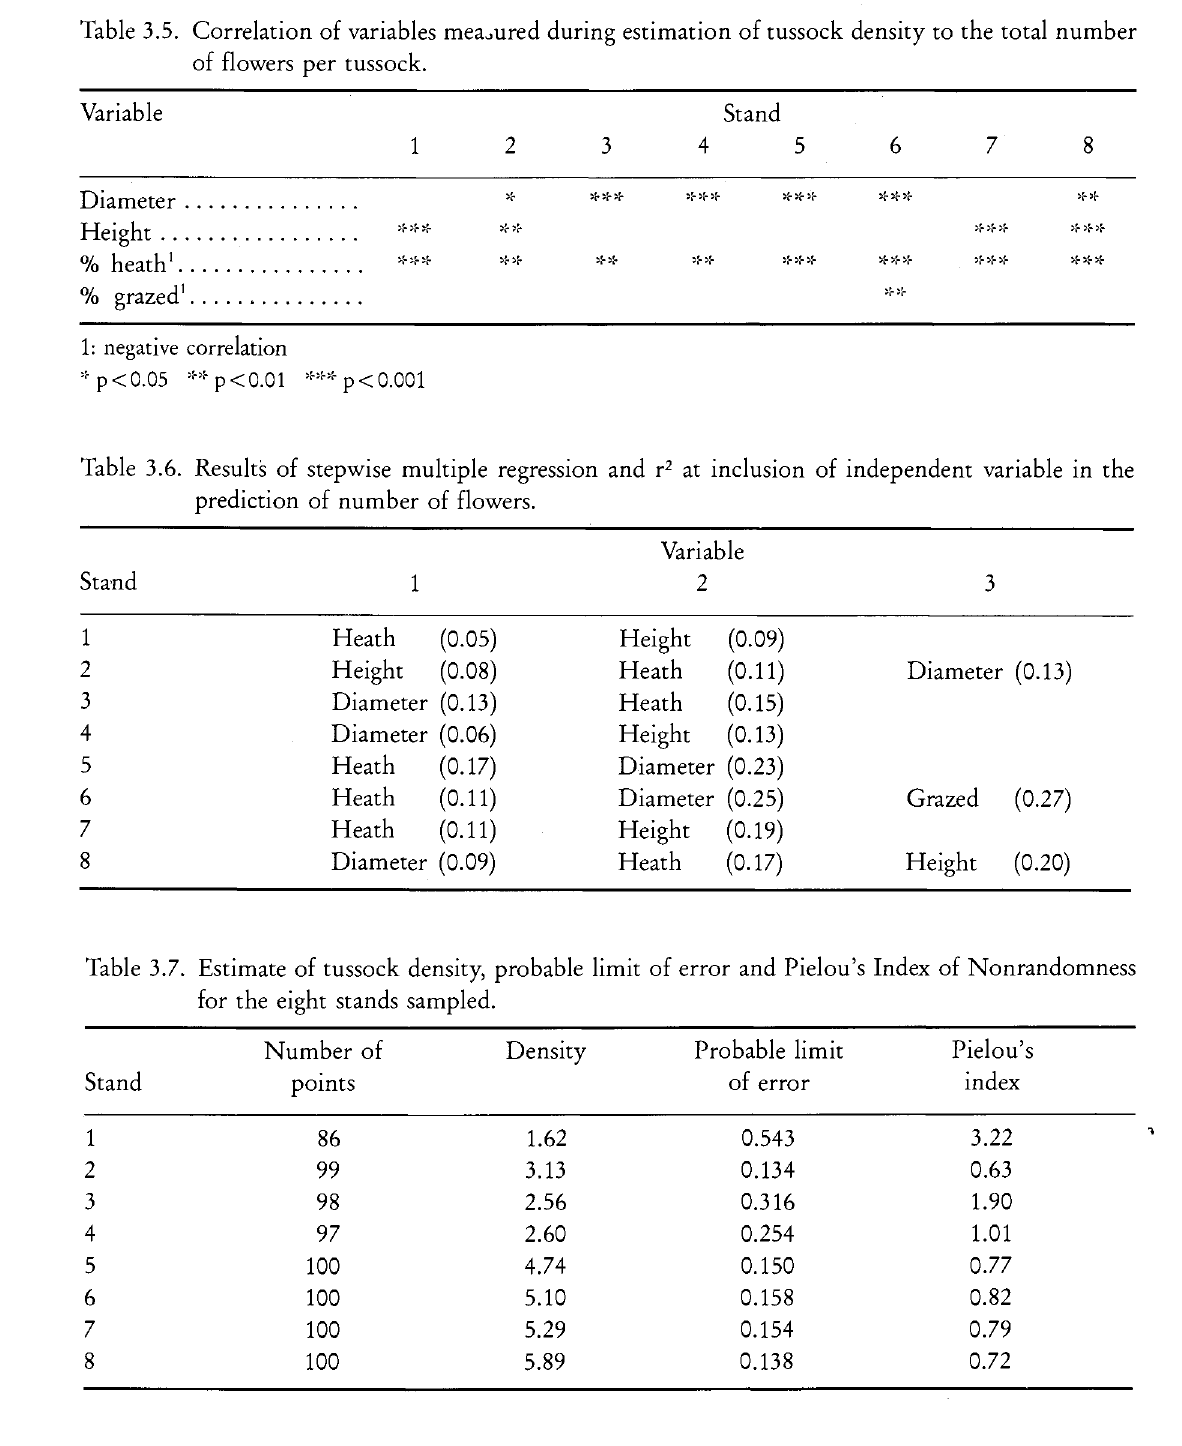
Table 3.5. Correlation of variables meajured during estimation of tussock density to the total number of flowers per tussock.